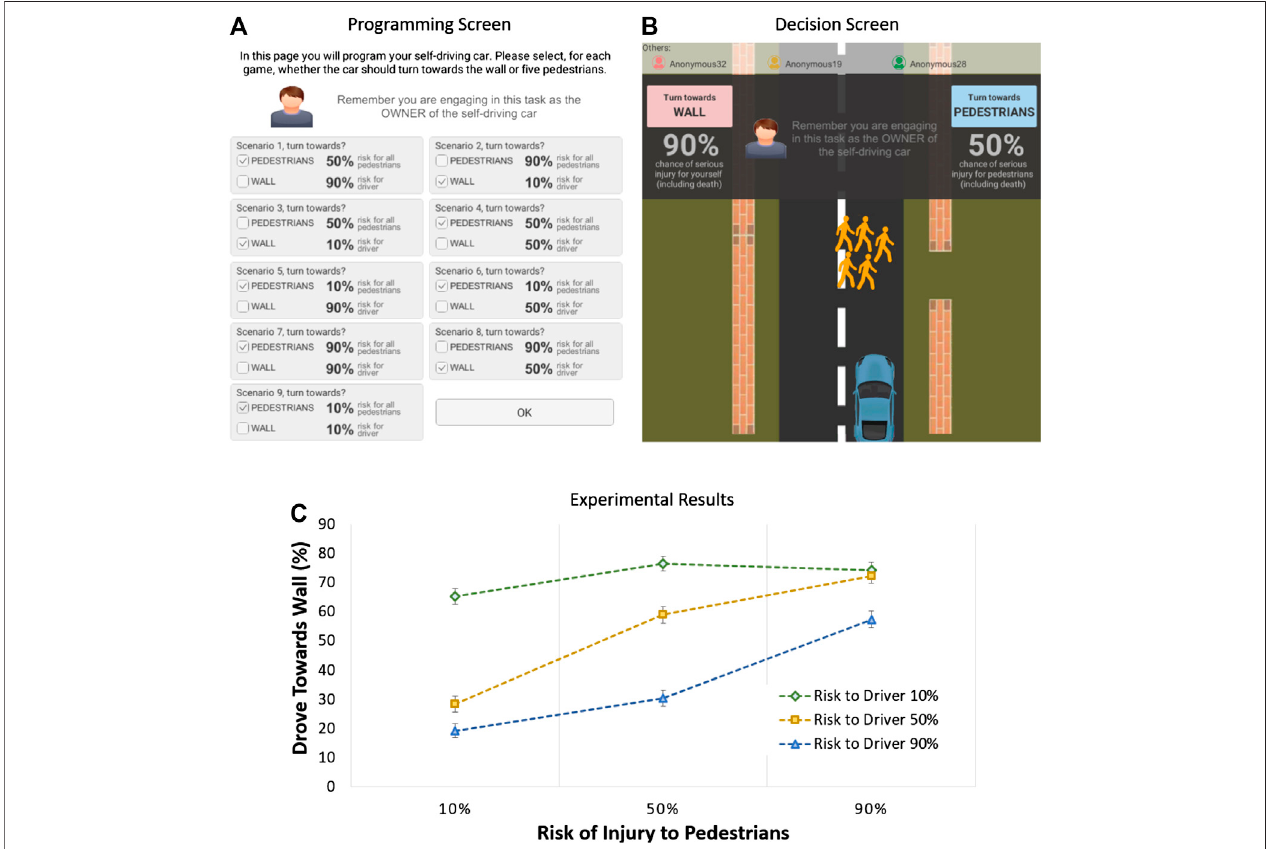
FIGURE 3 | Moral dilemma software and results in Experiment 2: (A) programming interface; (B) decision screen; (C) the in fl uence of risk of injury on utilitarian choice (error bars show standard errors).